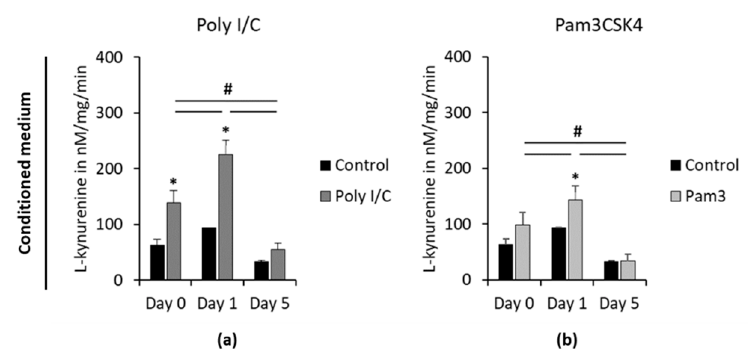
Figure 6. Continuing e ff ect of Poly I / C or Pam3CSK4 on IDO-1 enzymatic activity in hPDLSCs. Primary hPDLSCs were stimulated with 1 µ g / mL Poly I / C ( a ) or 1 µ g / mL Pam3CSK4 ( b ). After 48 h of incubation, the medium was changed to DMEM without any inflammatory stimuli. IDO-1 enzymatic activities were calculated via measuring L-kynurenine concentrations in CM immediately and one and five days after removing inflammatory stimuli. Determined L-kynurenine levels were normalized by the total protein amount per sample and the appropriate incubation times. The y-axis shows the L-kynurenine concentrations in nM / mg / min in a linear scale. All data are presented as mean ( ± S.E.M.) obtained from six independent experiments using hPDLSCs isolated from six di ff erent individuals. After stimulation of hPDLSCs with all TLR-2 and TLR-3 agonists, L-kynurenine levels in cell lysates were below the detection limit (data not shown). * p -value ≤ 0.05, significantly increased compared to unstimulated controls of the appropriate day; # p -value ≤ 0.05, significantly di ff erent between groups as indicated.